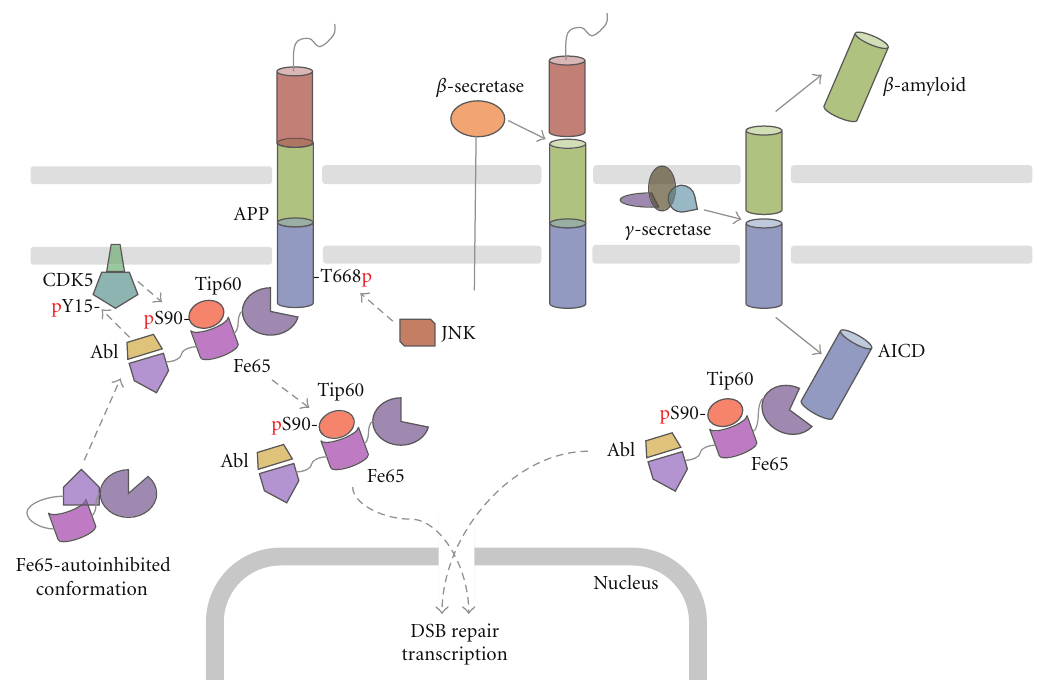
Figure 1: APP processing pathways involved in the activation and release of the AICD-associated complexes from the plasma membrane. Fe65 is in an autoinhibited conformation in the cytoplasm. The binding to the AICD triggers the exposure of Fe65 WW and PTB1 domains. These protein-protein domains elicit the recruitment to the subcortical domains of the plasma membrane of both c-Abl and Tip60. At the plasma membrane, c-Abl can phosphorylate and activate the protein kinase CDK-5 at Tyr15, and in turn, activated CDK-5 may phosphorylate Ser90 of Tip60. DNA damage or other unknown stimuli may then induce the release of the complex from the membrane through two complementary mechanisms: either by the activation of the γ -secretase or by JNK-dependent phosphorylation of Thr668 in the AICD. In spite of the preferred mechanisms involving the release of the Fe65-complex, it can be translocated to the nucleus where it activates transcription of target genes and is essential in the repair of the DNA double strand-breaks